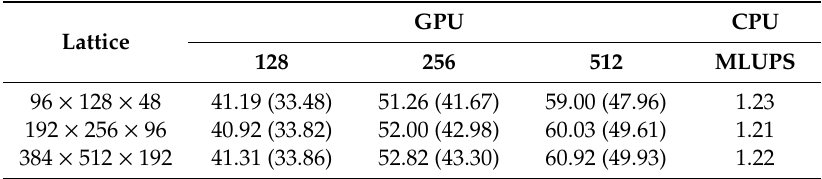
Table A1. Million lattice node updates per second (MLUPS) and speedup of GPU and CPU.